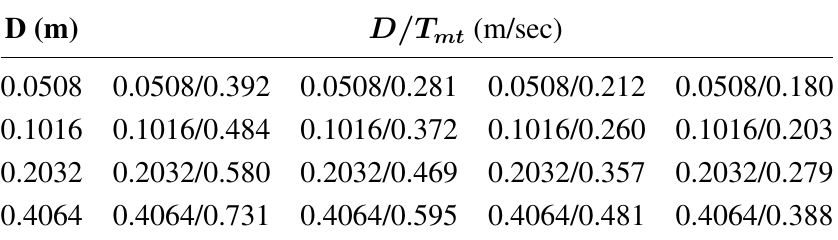
m/sec under different D (cid:48) s mt